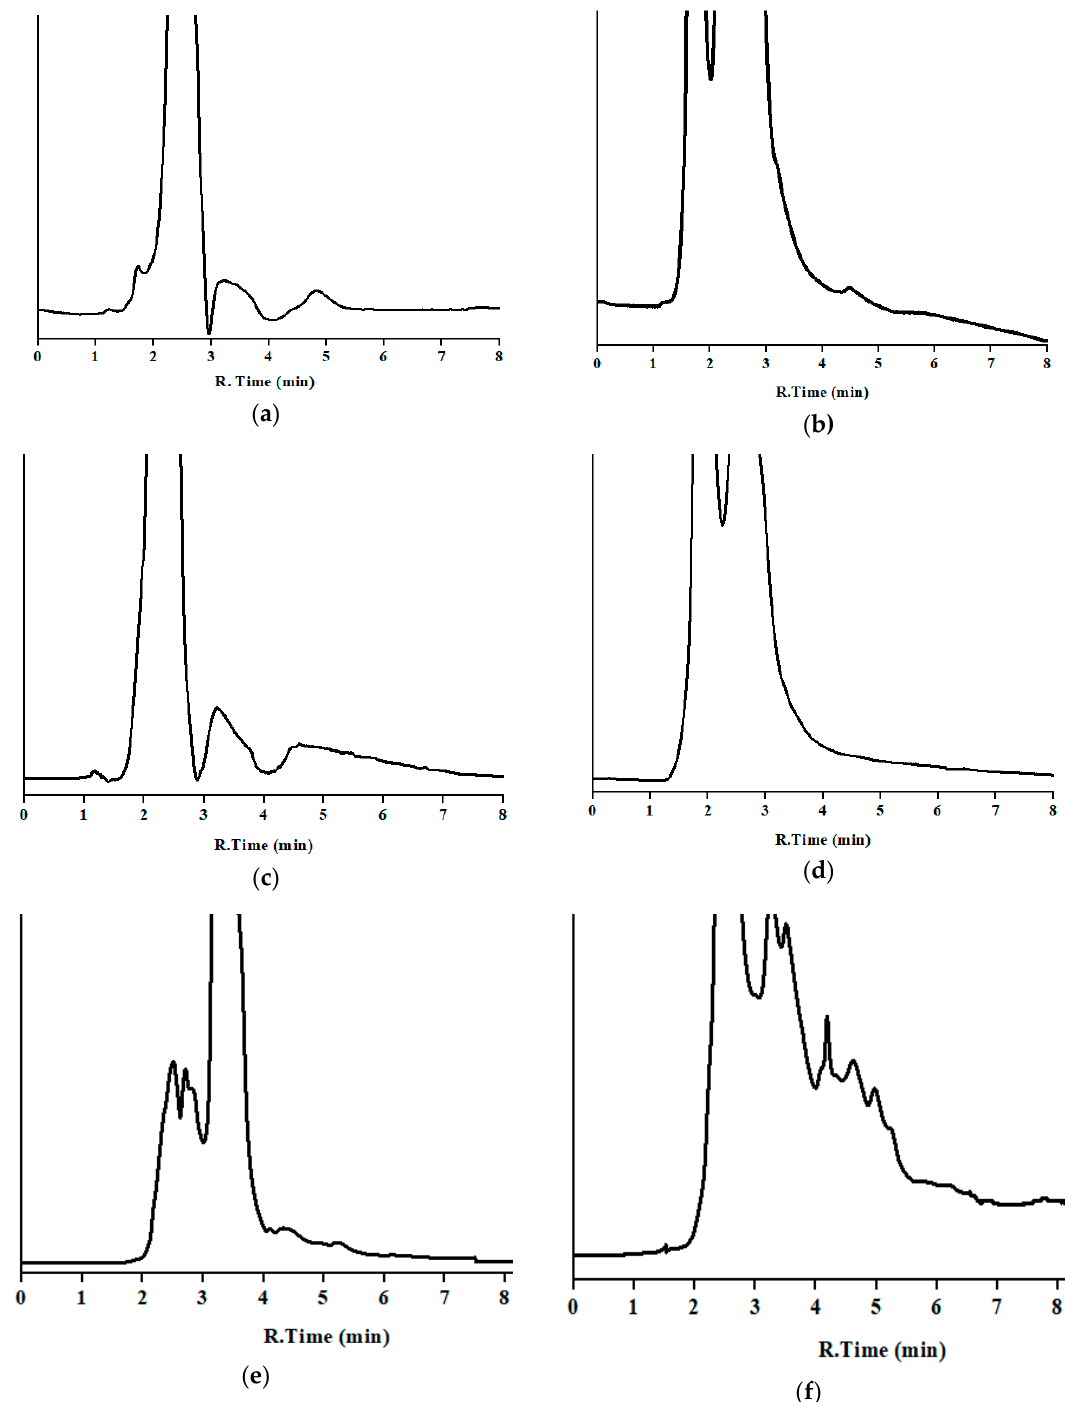
Figure 3. Chromatograms of blank samples in the optimum chromatographic conditions: ( a ) milk; ( b ) cheese; ( c ) butter; ( d ) curd; ( e ) urine; and ( f ) dung (y-axis is the absorbance in arbitrary units, and the same scale applies for Figures 2–4).